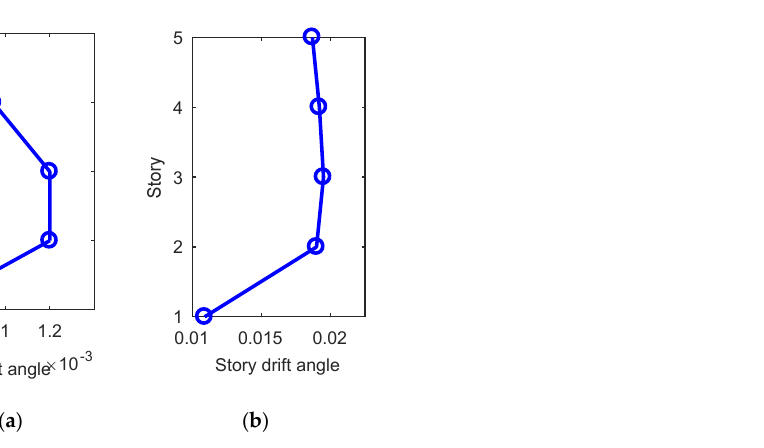
Figure 12. Max story drift angles of each story of the frame structure under a certain stochastic simulated seismic ground motion: ( a ) frequent earthquakes; ( b ) rare earthquakes.